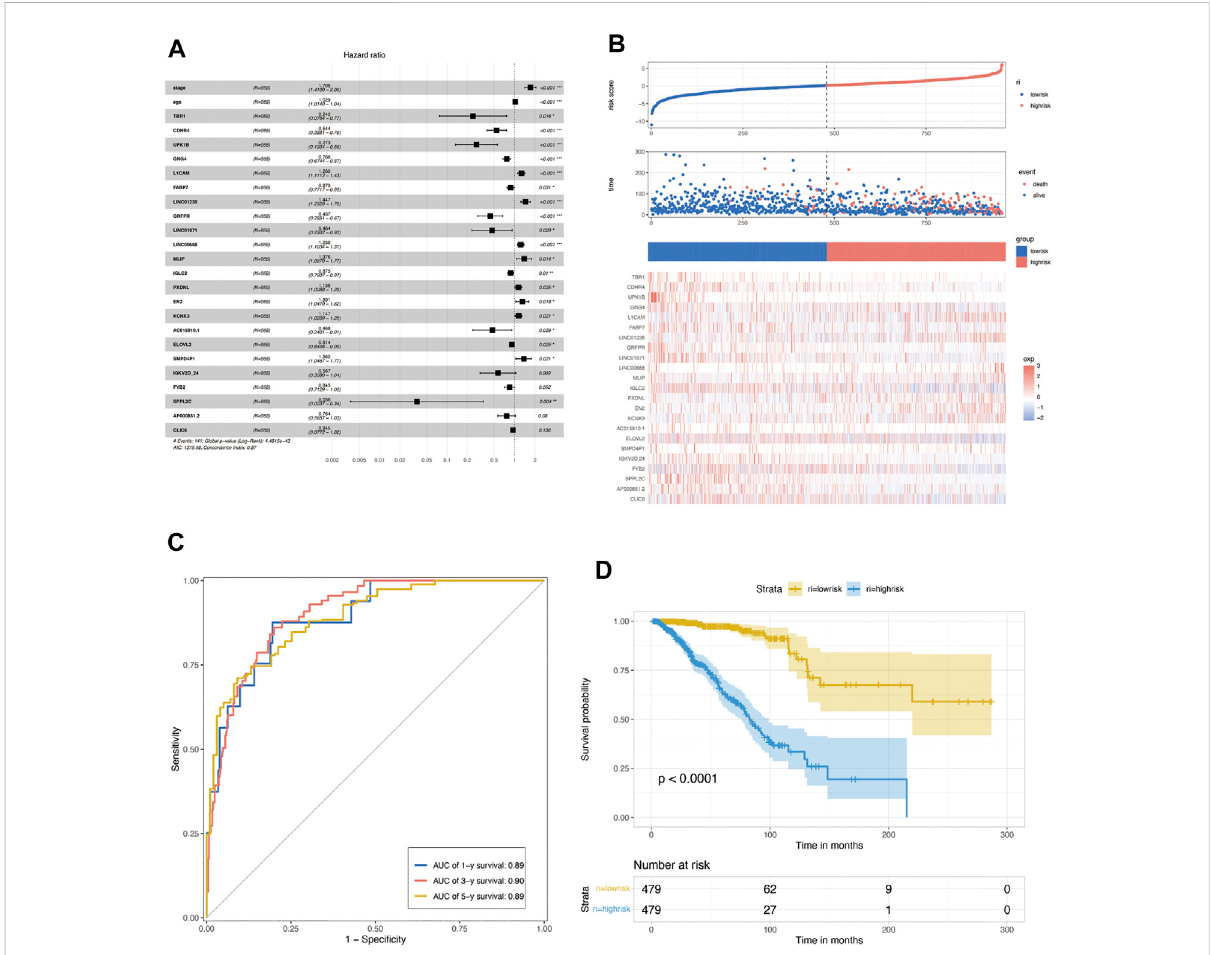
FIGURE 5 Constructionofmultivariate Coxregression. (A) MultivariateCoxproportional hazardmodelbasedonlasso deredundantgenesetintheTCGA training set. (B) Proportion of deaths in the training set in high- and low-risk groups as risk score values increased. Top: red, high-risk; blue, low-risk. Middle: red, death; blue, alive. Bottom: hierarchical clustering of 14 key molecules between low- and high-risk groups. (C) COX risk score ’ s time- dependent ROCcurvesfor 1,3,and5yearsbeforedeathintheTCGAtraining set.Inthetraining set, (D) Kaplan – MeiersurvivalanalysesforCOX low- and high-risk groups. ( p < 0.0001, log-rank